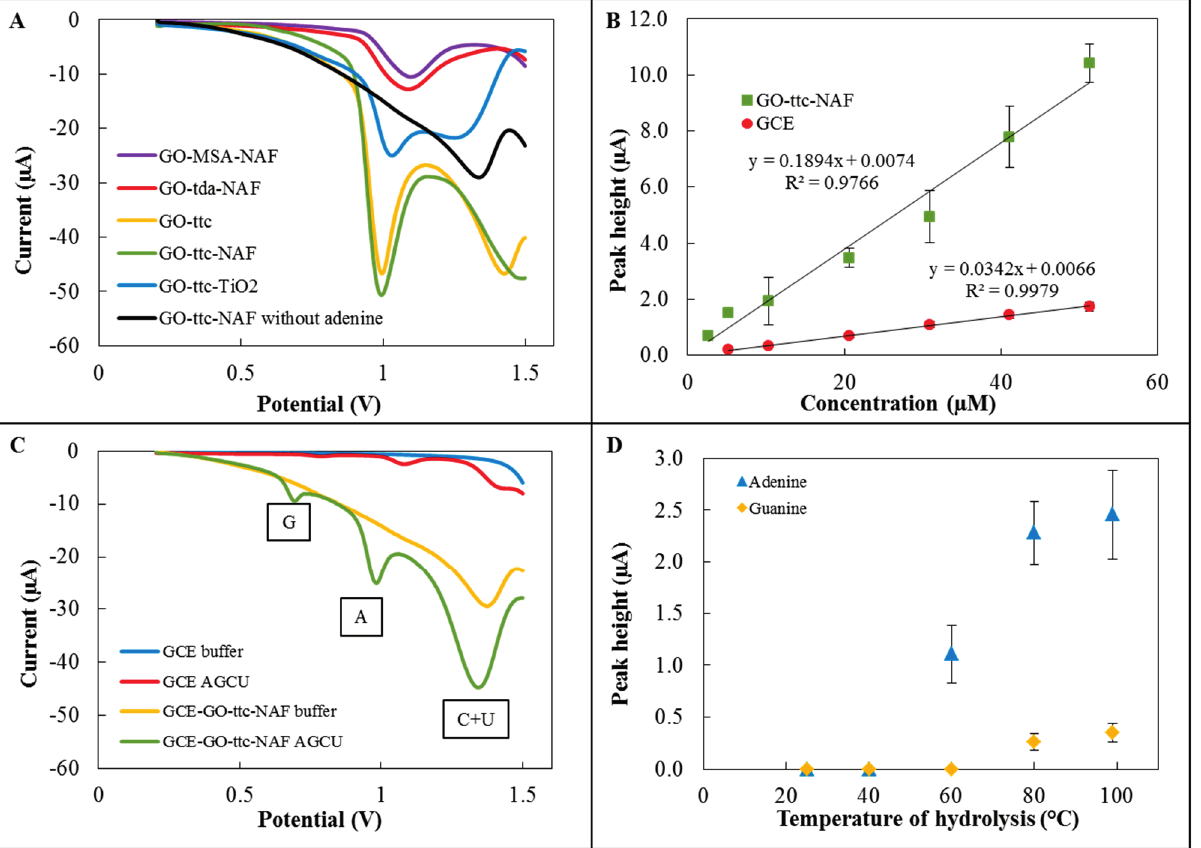
Figure 3. ( A ) Detection of 200 µM adenine on GCE modified by different graphene oxide; ( B ) Calibration curve of adenine on unmodified GCE and GCE modified by GO-ttc-NAF; repeated in triplicates; ( C ) Simultaneous detection of guanine (262 µM), adenine (51 µM) and cytosine (273 µM) with uracil (255 µM) by unmodified GCE and GCE modified by GO-ttc-NAF; ( D ) Optimization of hydrolysis temperature measured by GCE modified with GO-ttc-NAF, concentration of adenine and guanine was 9 µM and 4 µM